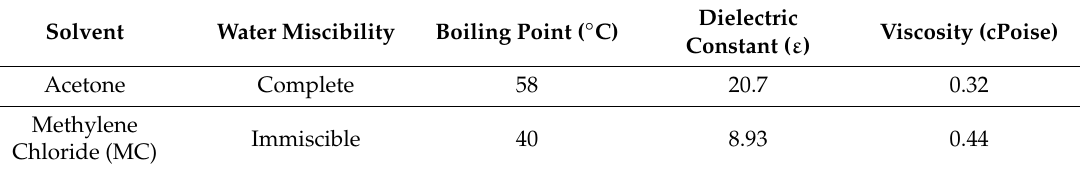
Table 1. Selected solvents intrinsic